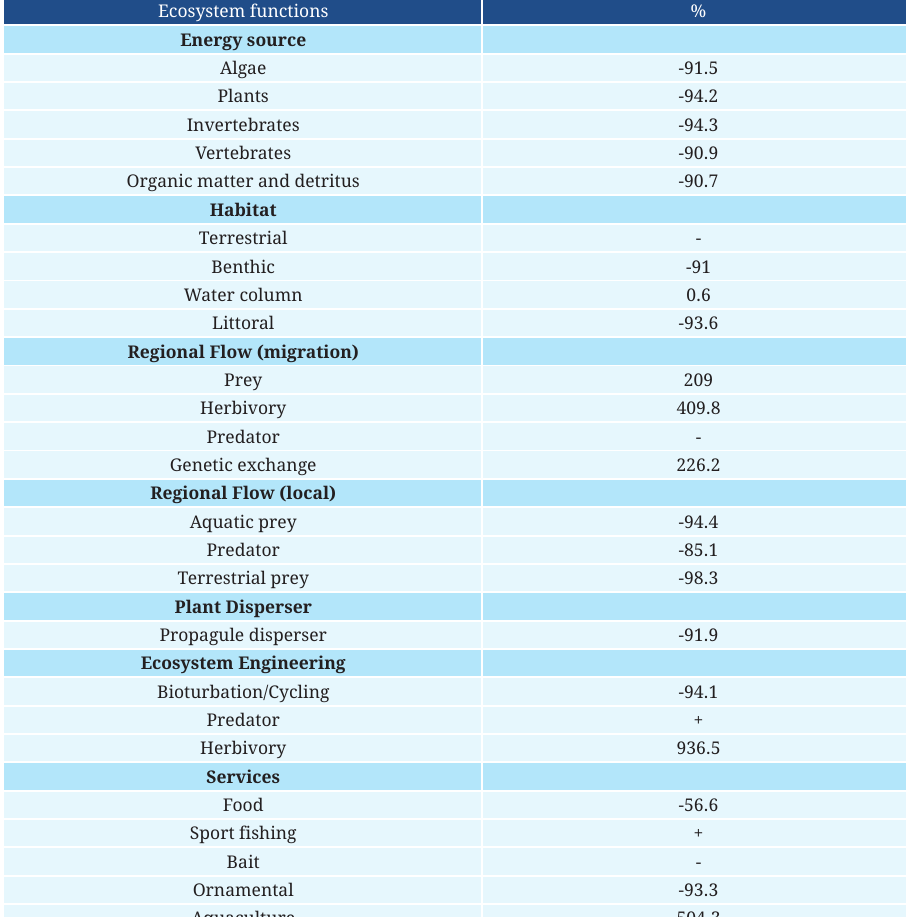
TABLE 3 | Increasing (positive values) and decreasing (negative values) trends in the intensity of ecosystem functions (trait-states) generated by fish populations, calculated from the variation in fish biomass between the first (Pre) and last (Post-5) periods. “+” = function added, absent in Pre but present in Post; “-” = function lost, present in Pre but absent in Post-5. Ecosystem functions % Energy